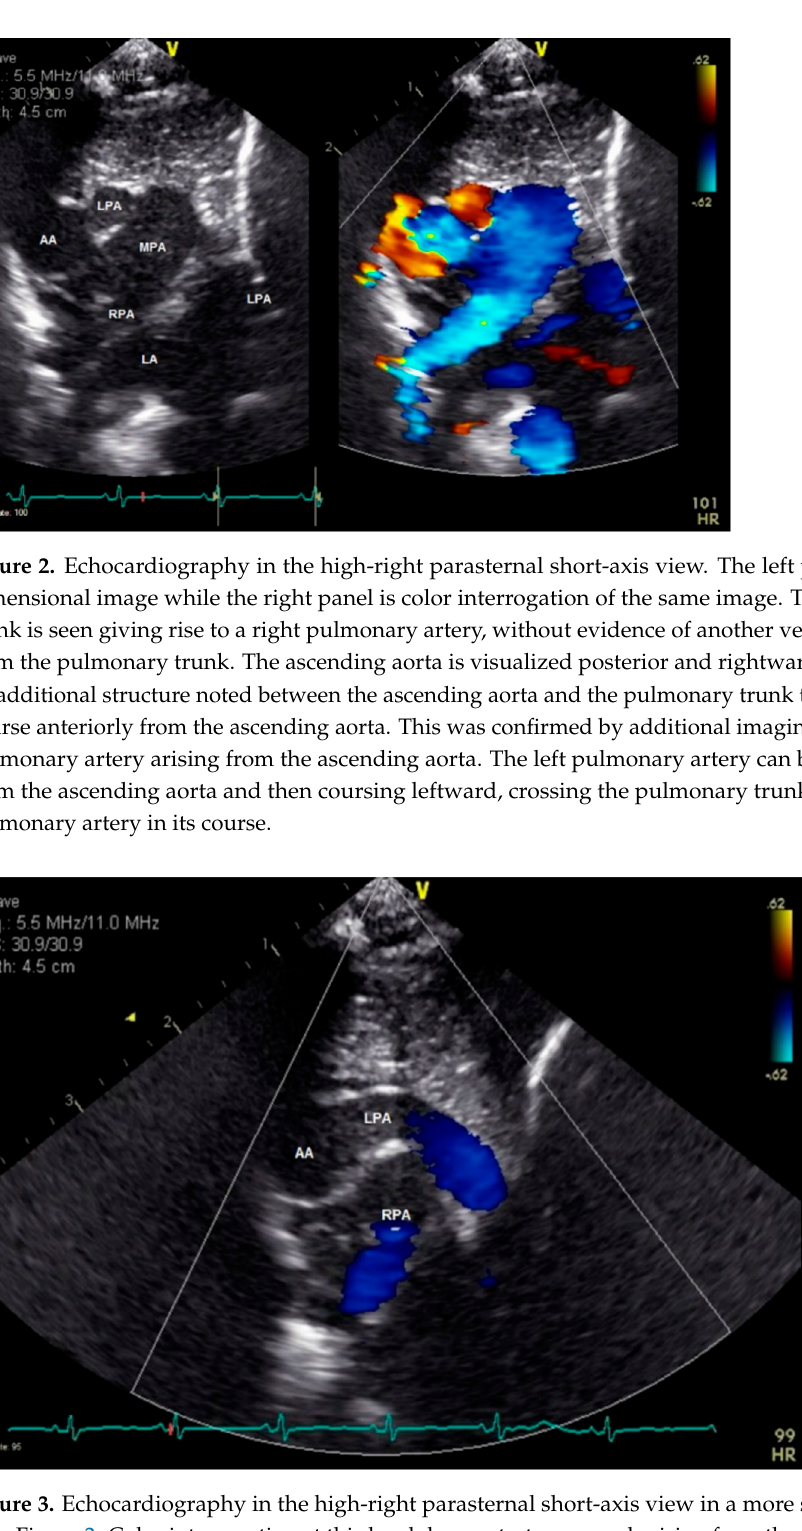
Figure 1. Two-dimensional echocardiography in the parasternal long-axis view. The aorta is seen arising from the left ventricle and there is a structure arising from the anterior aspect of the as- cending aorta. This was confirmed by additional imaging to be the left pulmonary artery.